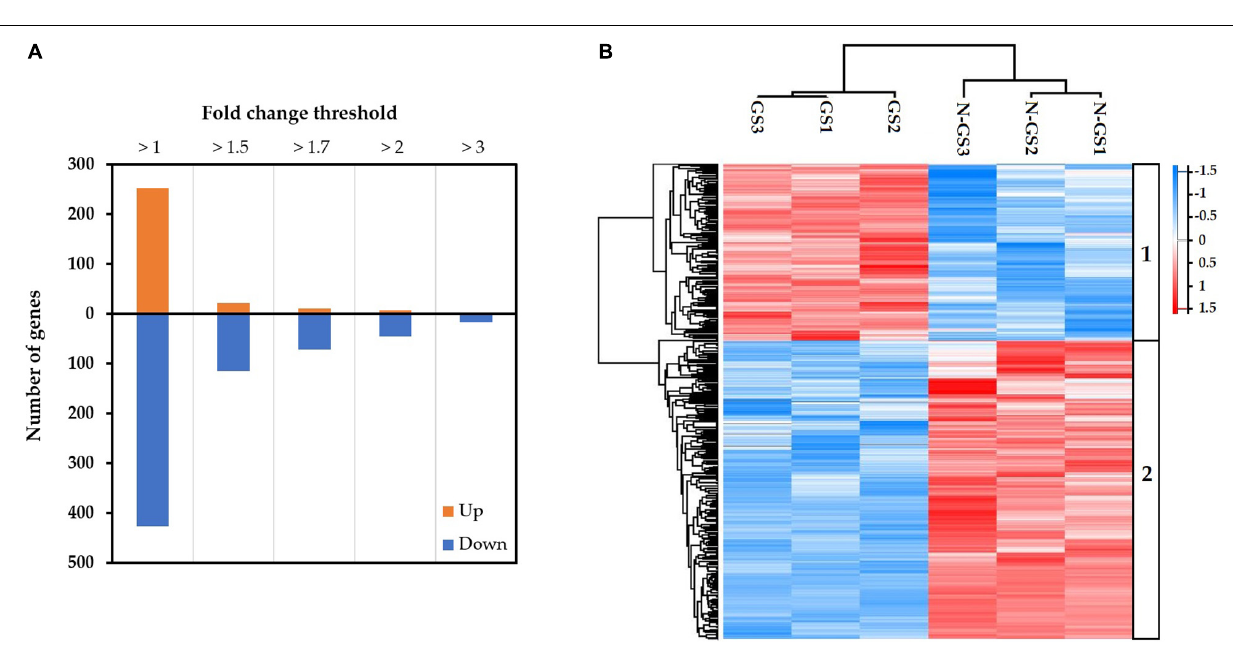
FIGURE 2 | (A) The number of transcripts significantly (FDR < 0.05) differentially up or downregulated in the germinating vs non-germinating spores, expressed in fold changes. (B) Heatmap (based on Z-scores of the normalised expression of transcripts) showing the expression patterns of differentially expressed genes